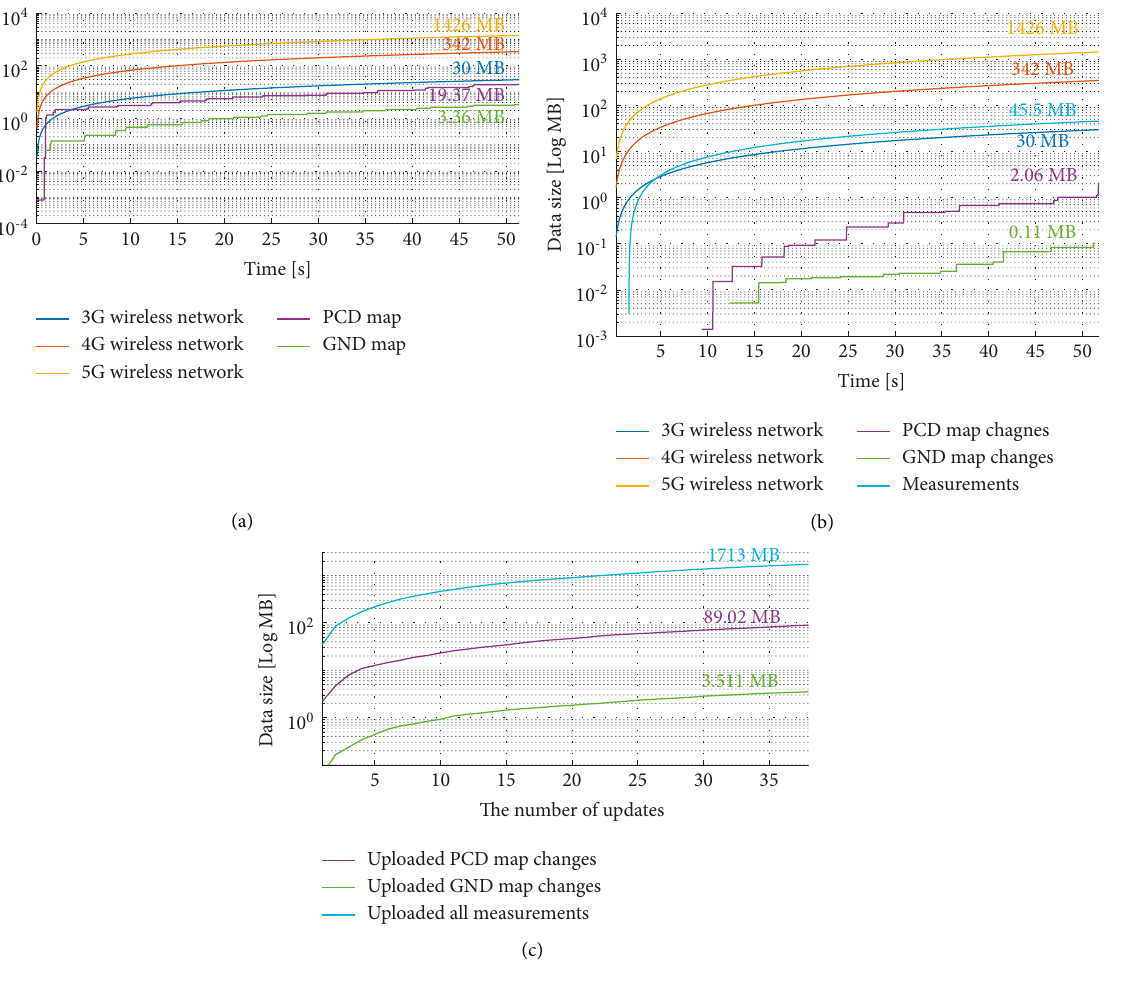
Figure 23: Traffic of wireless networks about (a) downloading the base map, (b) uploading map changes from a single vehicle, and (c) uploading map changes from crowd-sourcing